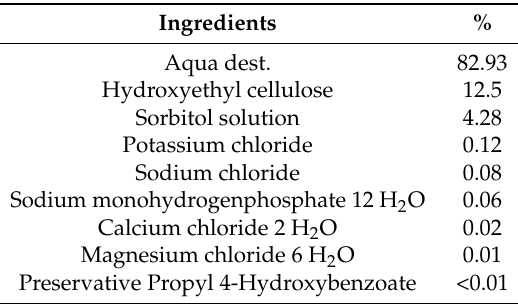
Table A2. Composition of artificial saliva.